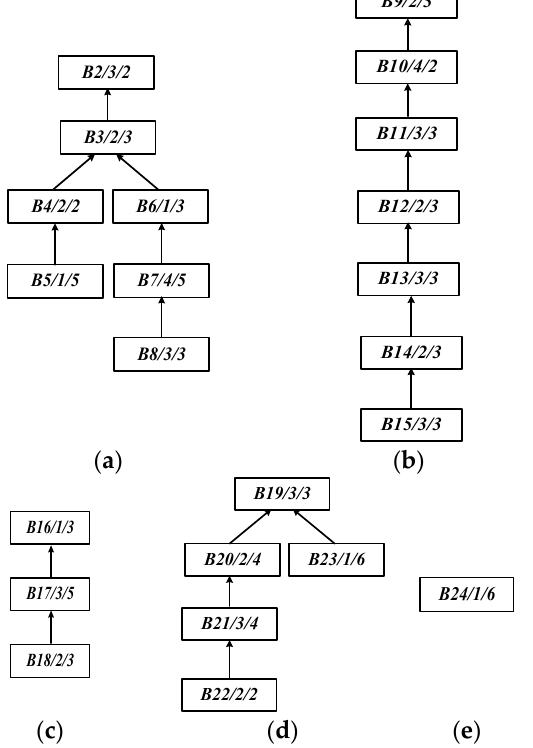
Figure 10. Operation strings after the first decomposition of complex product B : ( a ) Operation string T B1 ; ( b ) Operation string T B2 ; ( c ) Operation string T B3 ; ( d ) Operation string T B4 ; ( e ) Operation string T B5 .